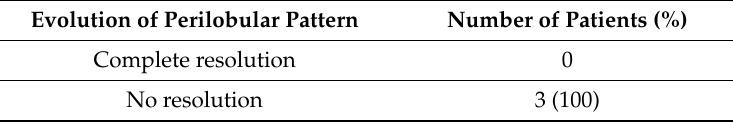
Figure 14. On the left: axial view. On the right: sagittal view. Perilobular pattern: the presence of arcade-like bands with blurred borders and thickening of the interlobular septa—resembling a Roman Arch (arrowheads), despite steroid therapy. Table 9. Evolution of the 3 patients with perilobular pattern.